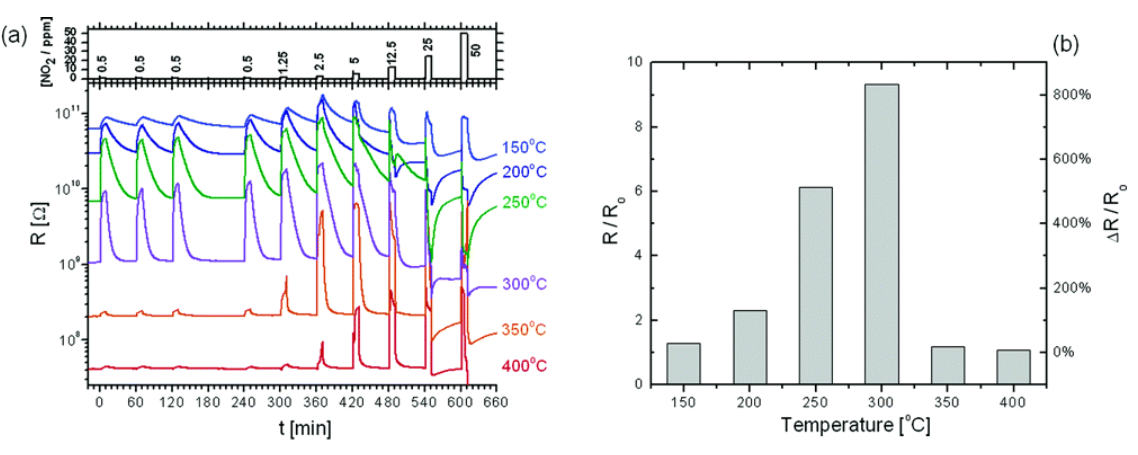
in dry air. R 2 0